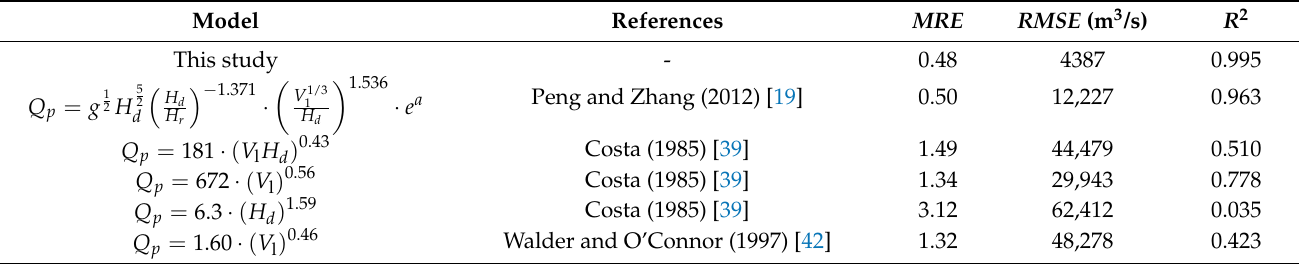
Table 3. Comparison of calculated effects of flood peak discharge calculation model.